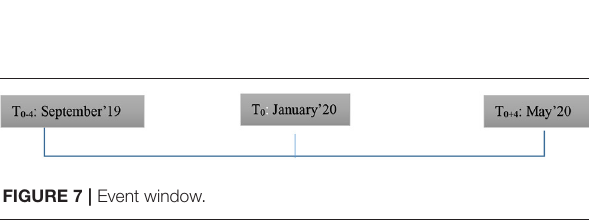
FIGURE 6 | Abnormal changes in policy interest rates over the event window: China.